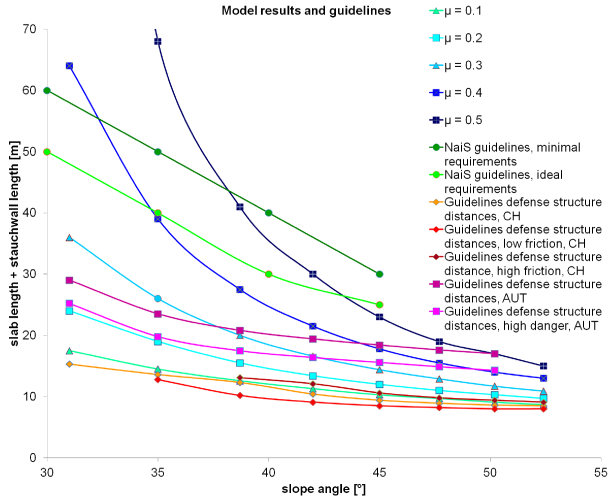
Figure 12. Comparison of guidelines with model results. Model cal- culations with friction values µ m = 0 . 1 correspond to the technical guidelines for avalanche prevention bridges. Maximum forest gap sizes proposed by the Swiss guidelines on sustainable forest man- agement (NaiS) are appropriate for low slope angles and high fric-